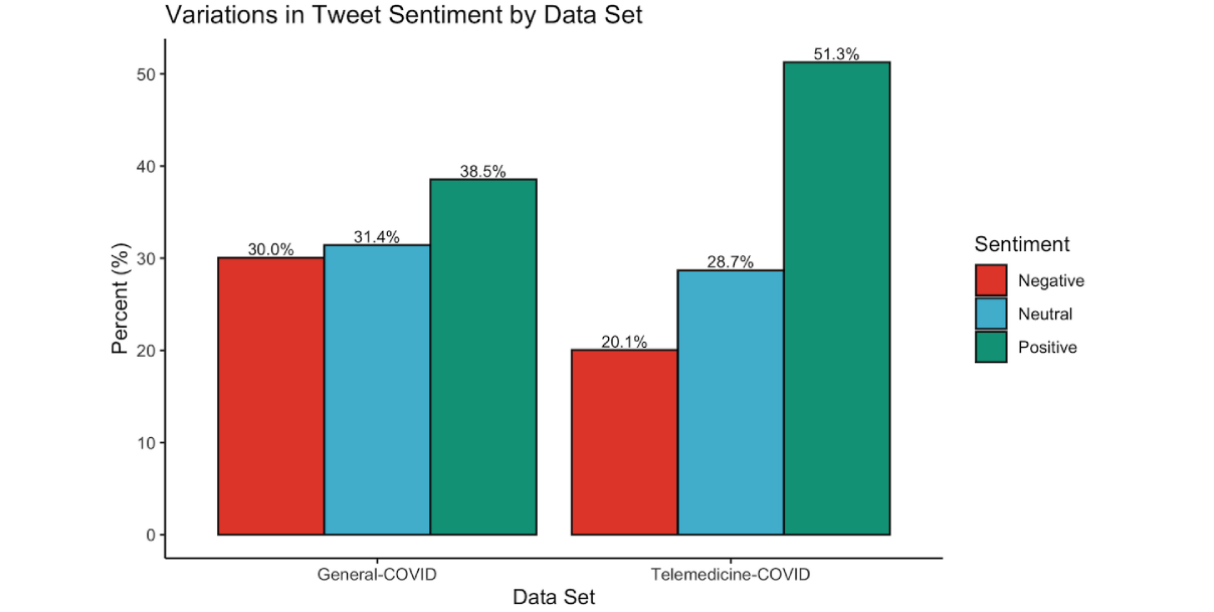
Figure 4. Variations in sentiment by tweet type (ie, telemedicine and COVID-19 vs COVID-19 only). A significantly higher proportion of tweets with a positive sentiment was found in the telemedicine-COVID data set than in the general-COVID data set ( P